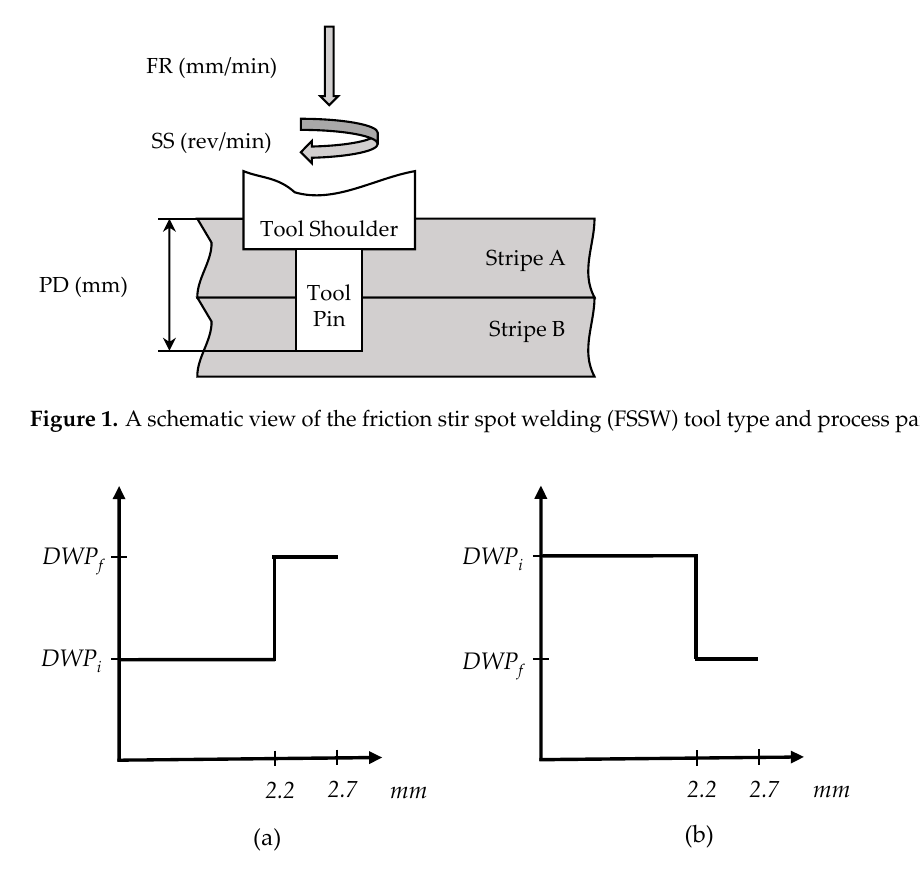
Figure 1. A schematic view of the friction stir spot welding (FSSW) tool type and process parame- ters.